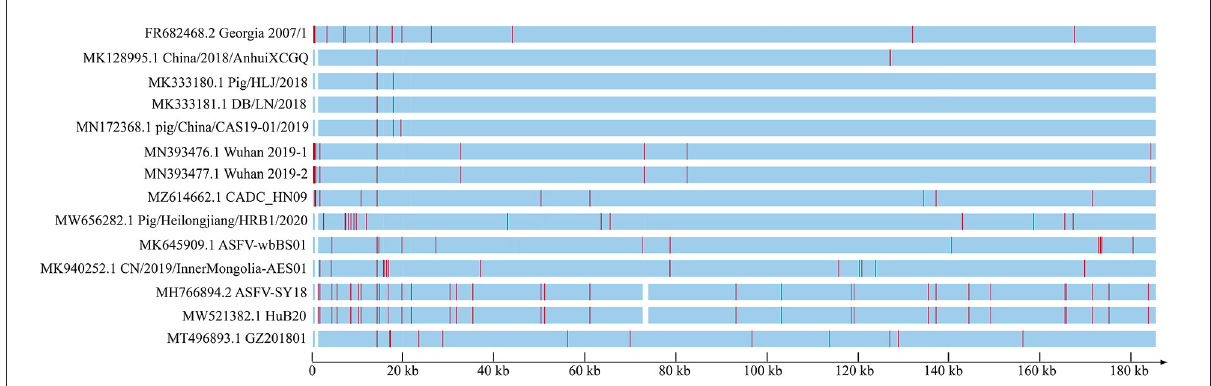
FIGURE3 ASFV genome from China and Georgia 2007/1, which has been considered as the original strain circulating around Eurasia since 2007, showing the entire genome frame map of all genome-wide sequences compared to GZ201801_2. Each red line represents a site mutation, and the vacant positions represent deletion